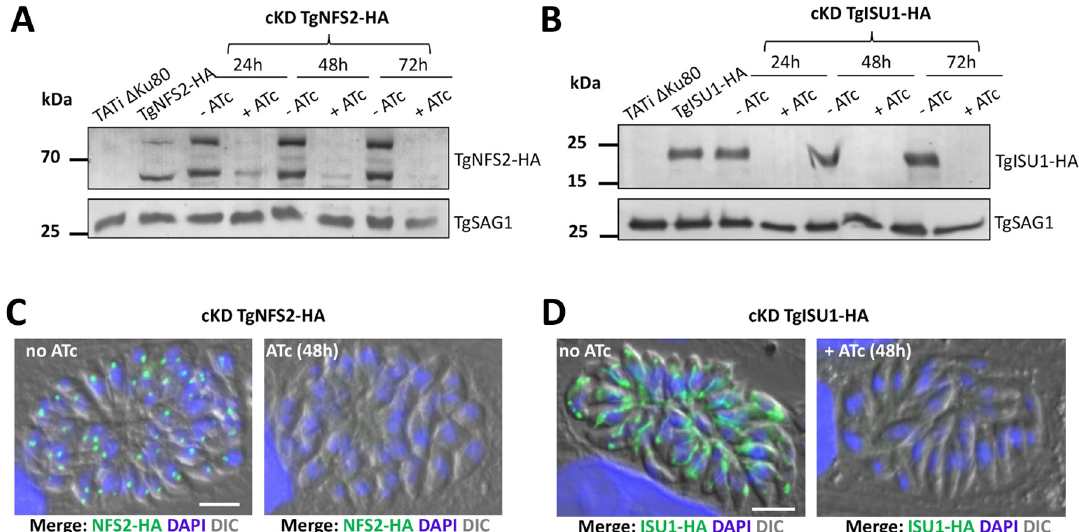
Fig 3. Efficient down-regulation of TgNFS2 and TgISU1 expression with anhydrotetracyclin (ATc). A) Immunoblot analysis with anti-HA antibody shows efficient down-regulation of TgNFS2 after 48h of incubation with ATc. Anti-SAG1 antibody was used as a loading control. B) Immunoblot analysis with anti-HA antibody shows efficient down-regulation of TgISU1 after 24h of incubation with ATc. Anti-SAG1 antibody was used as a loading control. C) and D) Immunofluorescence assays show TgNFS2 and TgISU1 are not detectable anymore after 48h of incubation with ATc. Scale bar represents 5 μ m. DNA was labelled with DAPI. DIC: differential interference contrast.